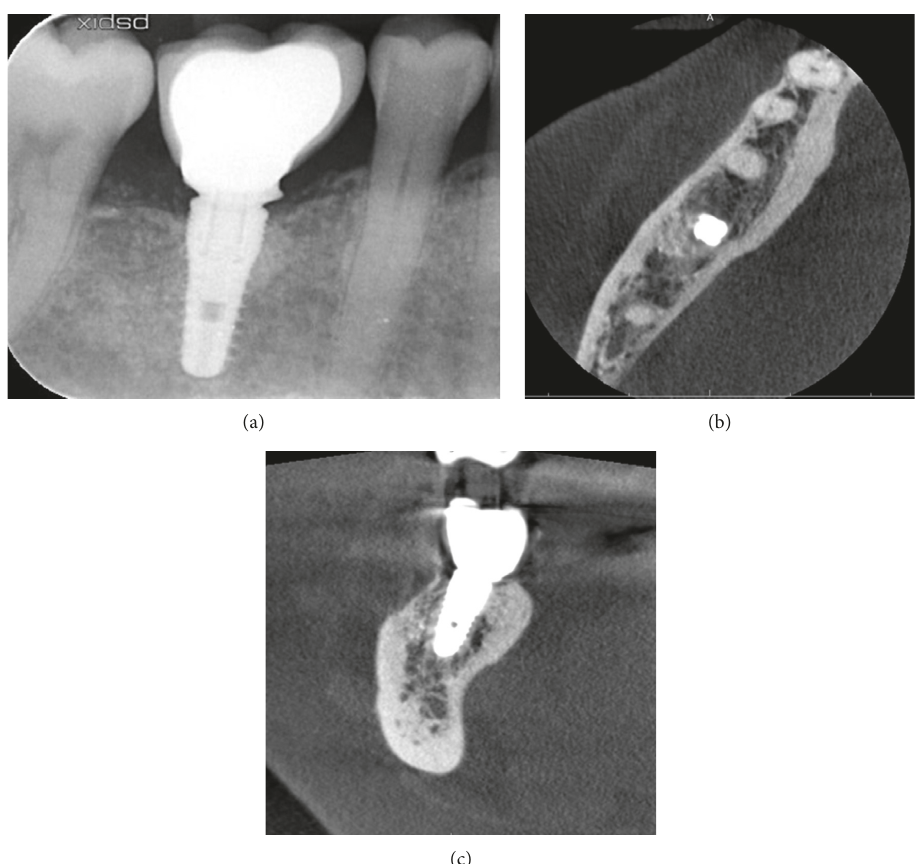
Figure 13: Radiological examination two years after loading of the implant: periapical X-ray and axial and coronal planes of the CBCT showing the preservation of the dimensions of the regenerated